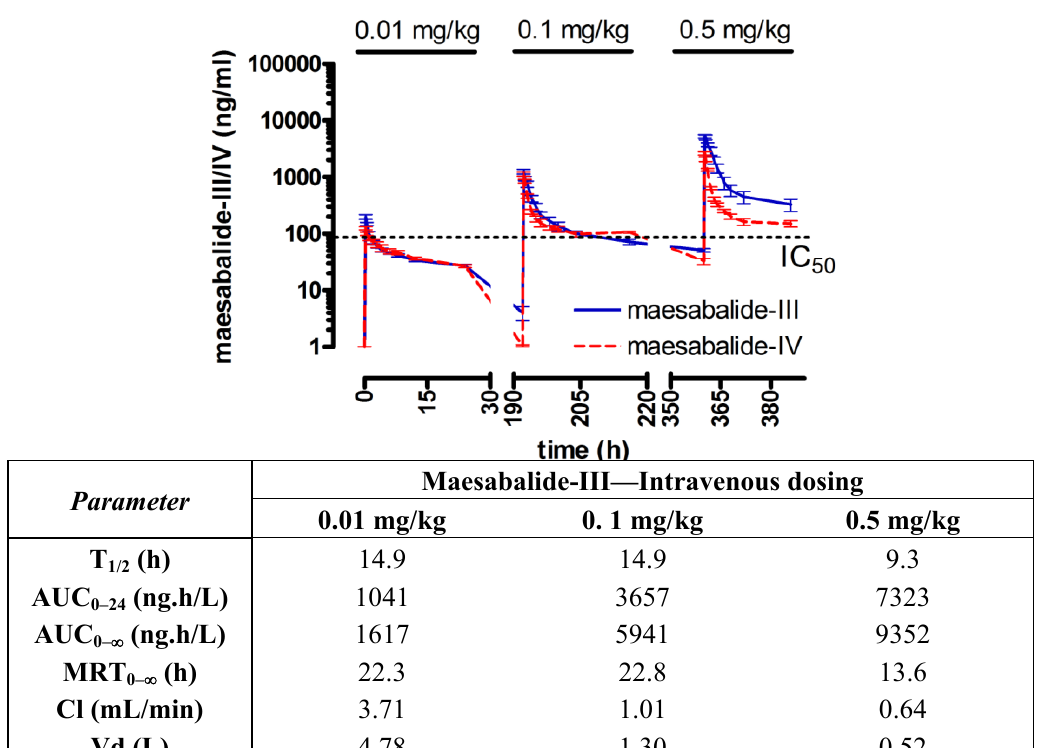
Figure 4. Plasma kinetics of maesabalide-III (n = 4) and maesabalide-IV (n = 4) after intravenous dose-escalation (0.01, 0.1 and 0.5 mg/kg at weekly intervals) in dogs. The dashed line represents the in vitro IC value of PX-6518 against intracellular amastigotes 50 Leishmania infantum (taken from ref. [15]). Pharmacokinetic parameters were similar for both maesabalides and are listed for maesabalide-III in the